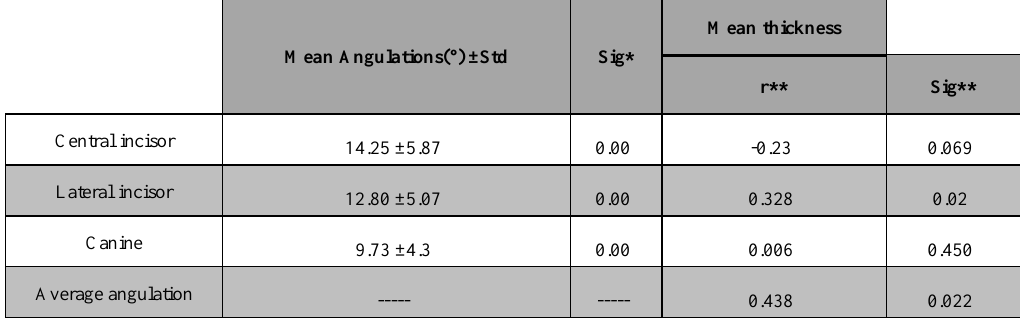
Table 5. Mean Angulations of anterior teeth and correlation with facial bone